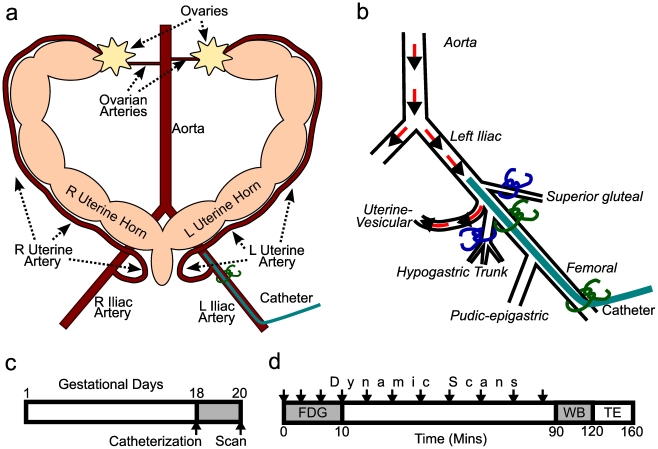
A model for selective fetal exposure.(a) The vast majority of blood flow to each uterine horn is supplied by each horn's uterine artery [24], which derives from the iliac artery. Therefore, infusate from a catheter appropriately placed in the left iliac artery should experience first pass exposure to fetuses in the left, but not right, uterine horn. The fetuses in the right uterine horn thus serve as internal controls. (b) In surgical approach “A”, ligatures (green) were tied around the left internal iliac artery just inferior to the uterine artery take off and around the femoral artery. Surgical approach “B” included additional ties (blue) around the left superior gluteal and hypogastric trunk arteries. (c) Experimental time-line. (d) Dynamic PET of the abdomen was initiated upon infusion of FDG, followed by a whole-body scan (WB) at 90-120 minutes, transmission and emission contamination scans (TE) at 120-160 minutes, and tissue collection after euthanasia at 160 minutes.